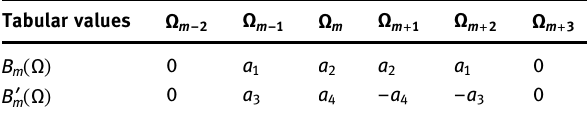
Table 1: Tabular values of quartic hyperbolic B - spline and derivatives Tabular